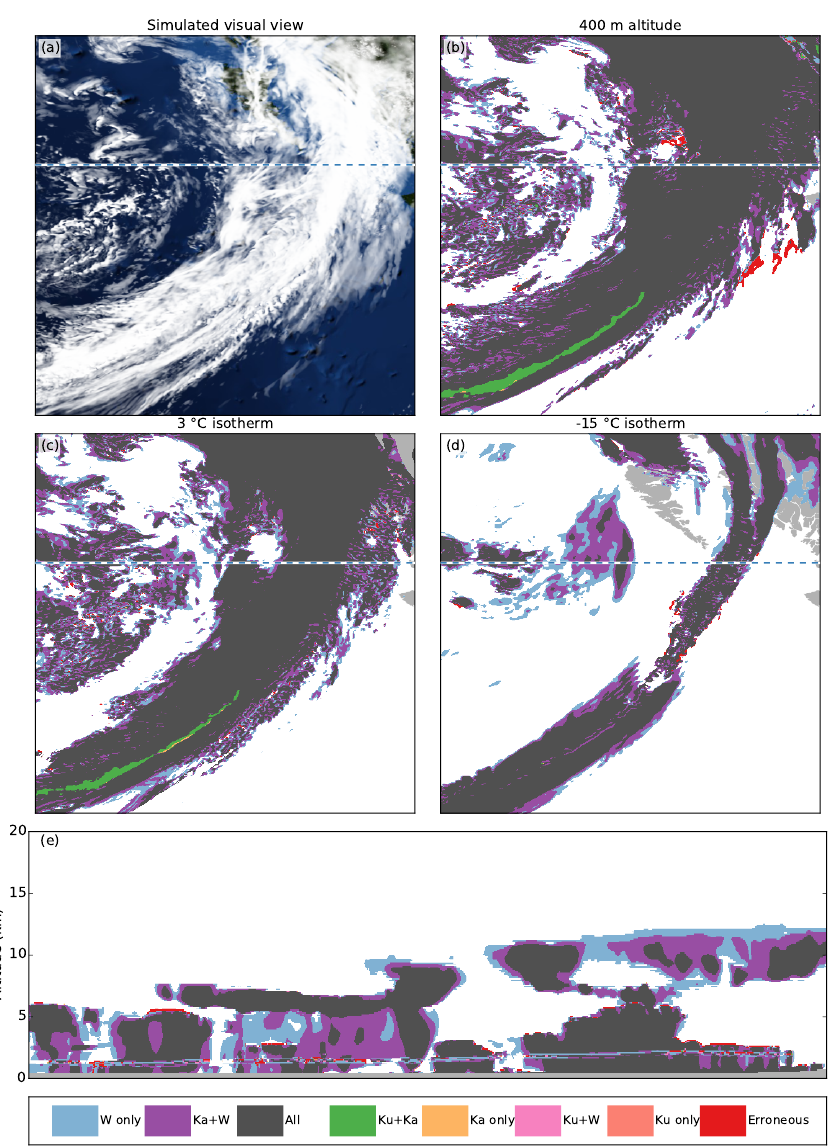
Figure 16. As in Fig. 6, but for the midlatitude front (Sect. 5.7; FRO in Fig. 3).